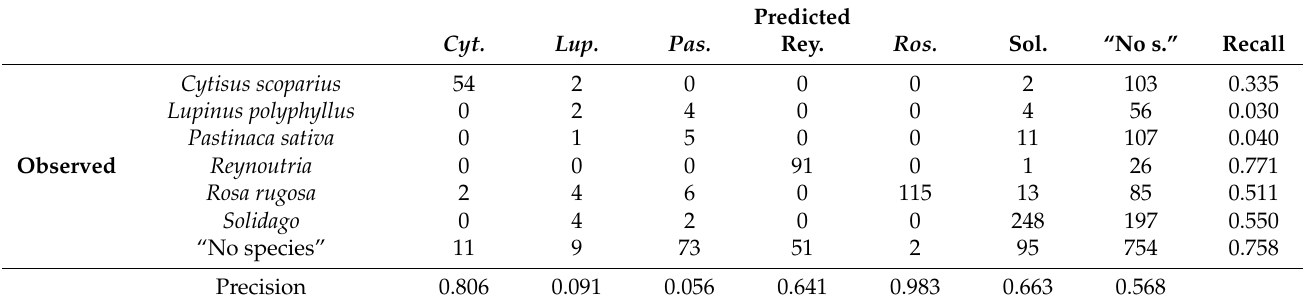
Table 3. Confusion matrix of the ResNet50V2 (ImageNet weights, max pooling, and 768 × 1024 px input images) model predictions on the test